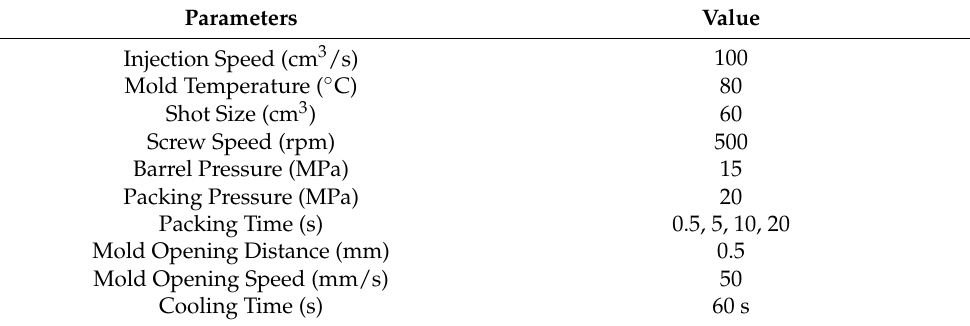
Table 3. MO-FIM molding processing conditions.